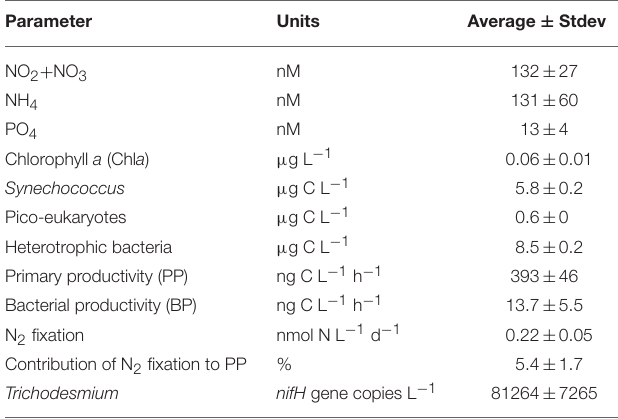
TABLE 2 | The initial chemical and biological properties of the Cretan Sea sub-surface water during May 9th 2012, before amendments were